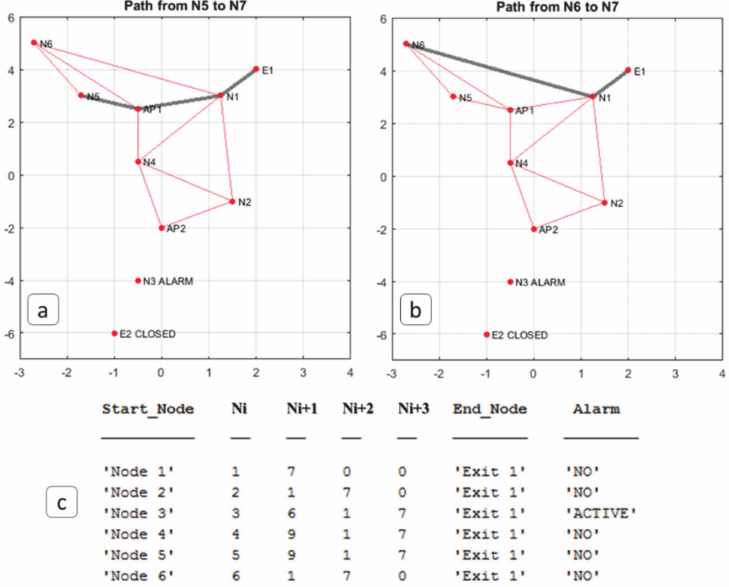
Figure 15. Example of the safest and fastest paths provided by the Algorithm 3 in case of an environmental / structural alarm at node 3 (N3), for people at ( a ) nodes 5 (N5) and ( b ) 6 (N6), and ( c ) is a table that shows the overall